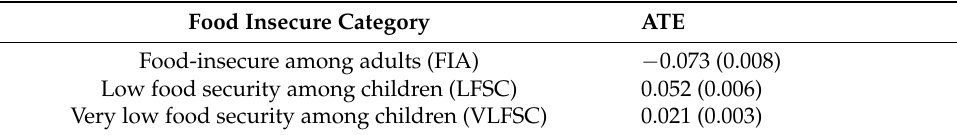
Table 2. Average treatment effects (ATE) of SNAP on probabilities of food insecurity conditional on FI >